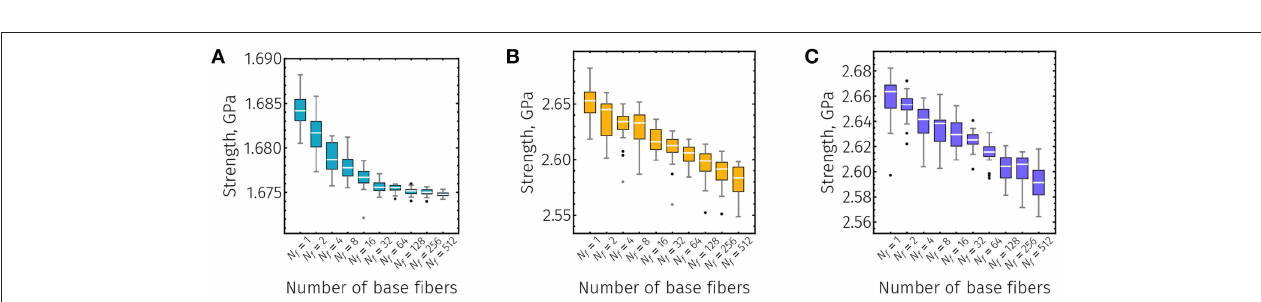
FIGURE 8 | Initial modulus box-whisker plots (20 independent simulations for each structure size) of CNC films with approximate base fiber lengths (A) L = 50nm, (B) L = 150nm, and (C) L = 300nm. Number of fibers ( N f ) refers to number of CNC fibers in series within the simulation volume and scales linearly with simulation size along the direction of loading. White horizontal lines, colored box, gray vertical lines, and black dots indicate the median, interquantile range (IQR) between 3rd and 1st quantiles, range (of all data within ± 1.5 × IQR), and outliers (points outside the range), respectively.